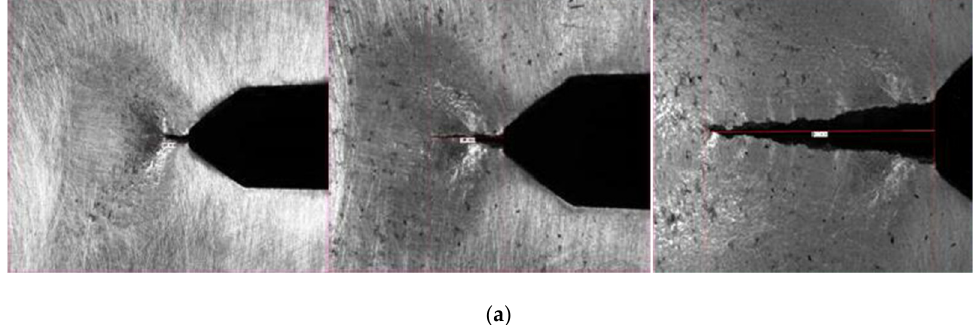
Figure 12. Growth speed vs. intensity factor. ( a ) Bembézar Stringers, m = 3.29; C = 6 × 10 − 13 . ( b ) Bembézar Main Chords, m = 3.41; C = 3 × 10 13 .